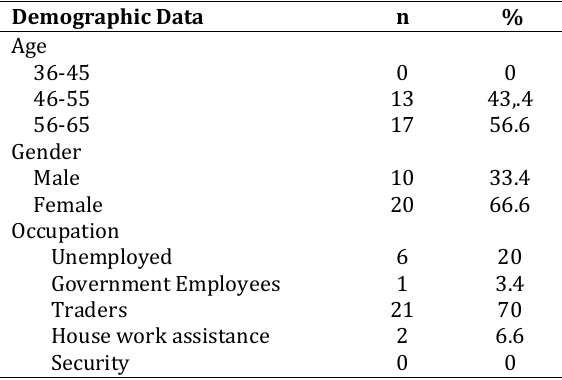
Table 1. Frequency Distribution of Age, Gender and Profession (n=30) Demographic